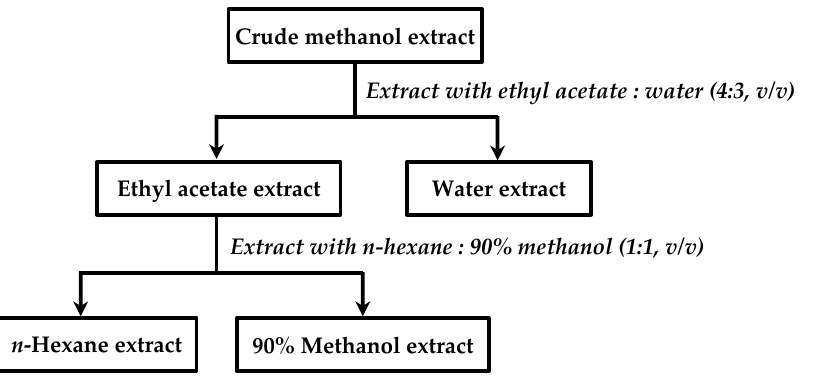
Figure 1. Partial extraction procedure.